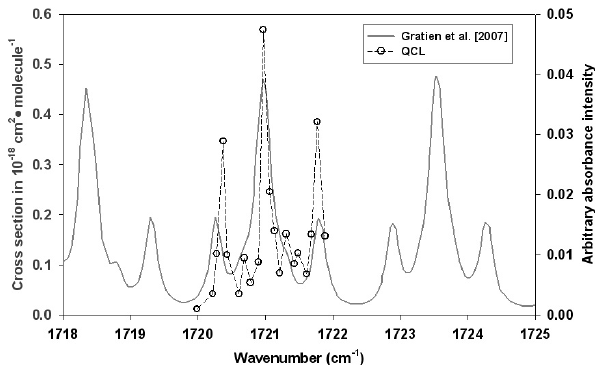
Fig. 1. Peak absorption strength of HCHO as a function of wavenumber (cm − 1 ) used to determine the target for ambi- ent HCHO detection. Left y-axis is ν 2 absorption cross sec- tion ( × 10 − 18 cm 2 molecule − 1 ; gray line) measured by Gratien et al. (2007) and the right y-axis is an arbitrary absorbance (open cir- cle and dashed line) obtained from experiments with the quantum cascade laser (QCL) spectrometer. HCHO of about 11.8ppm from a permeation system was used in the multipass cell at